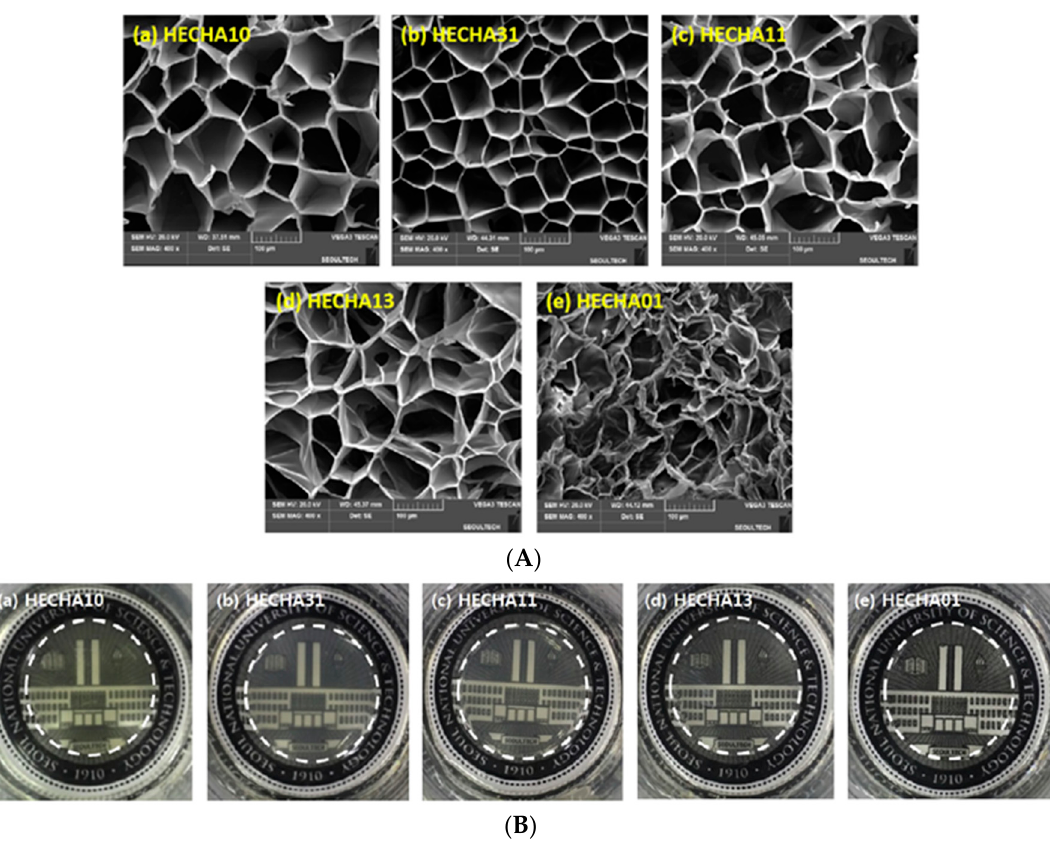
Figure 11. ( a ) Scanning electron microscope (SEM) images of cross-sections of the hydroxyethyl cellulose/hyaluronic acid (HECHA) hydrogels (the initial magnification was 400); ( b ) images of HECHA hydrogels: the white dotted line indicates the shape of the hydrogel; all hydrogels appeared transparent, and an increase of HA ratio was associated with greater transparency. [116].